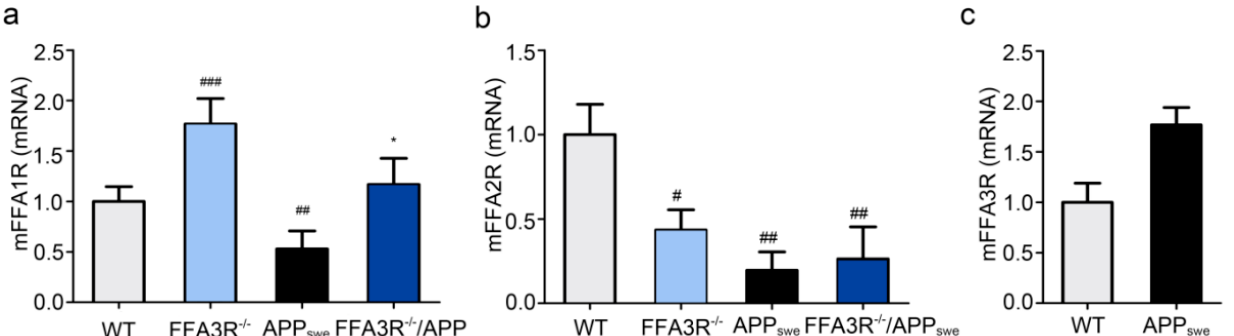
Figure 2. Comparative expression of FFARs in hippocampus of WT and transgenic mice. mRNA